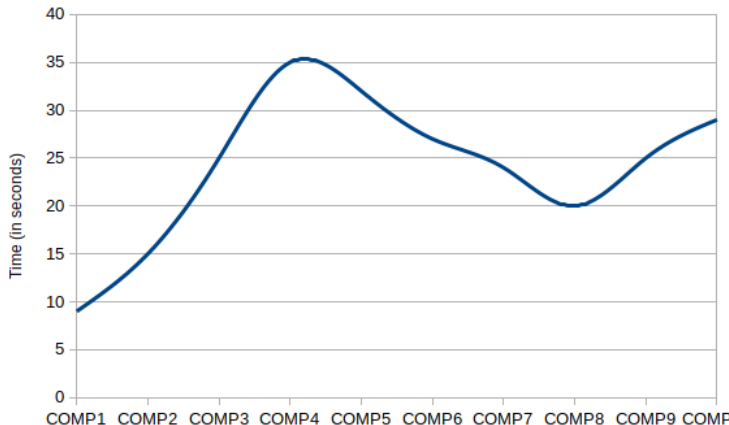
Figure 15. Time spent on